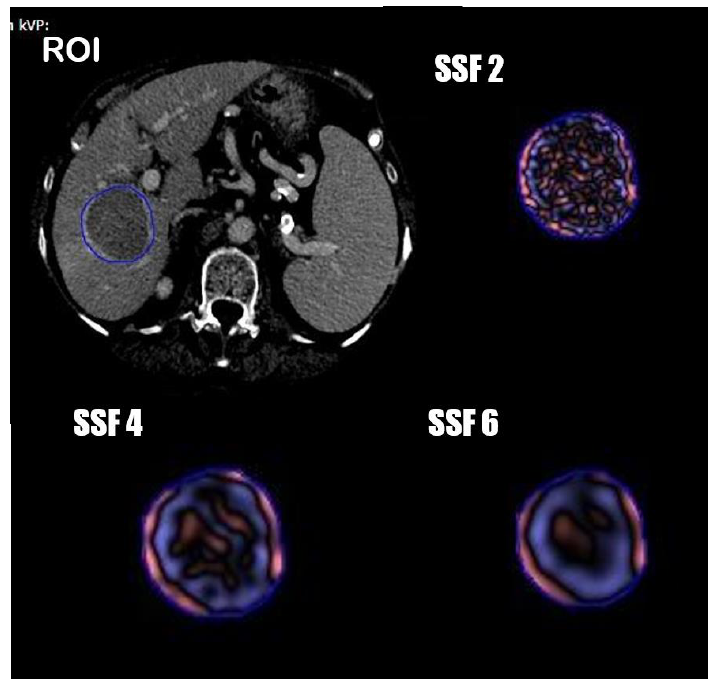
Figure 1. Segmentation process and spatial scale filters (SSF) application.